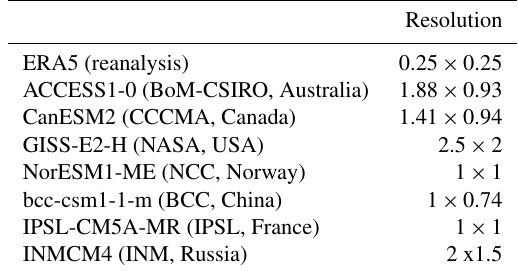
Table 1. Climate data